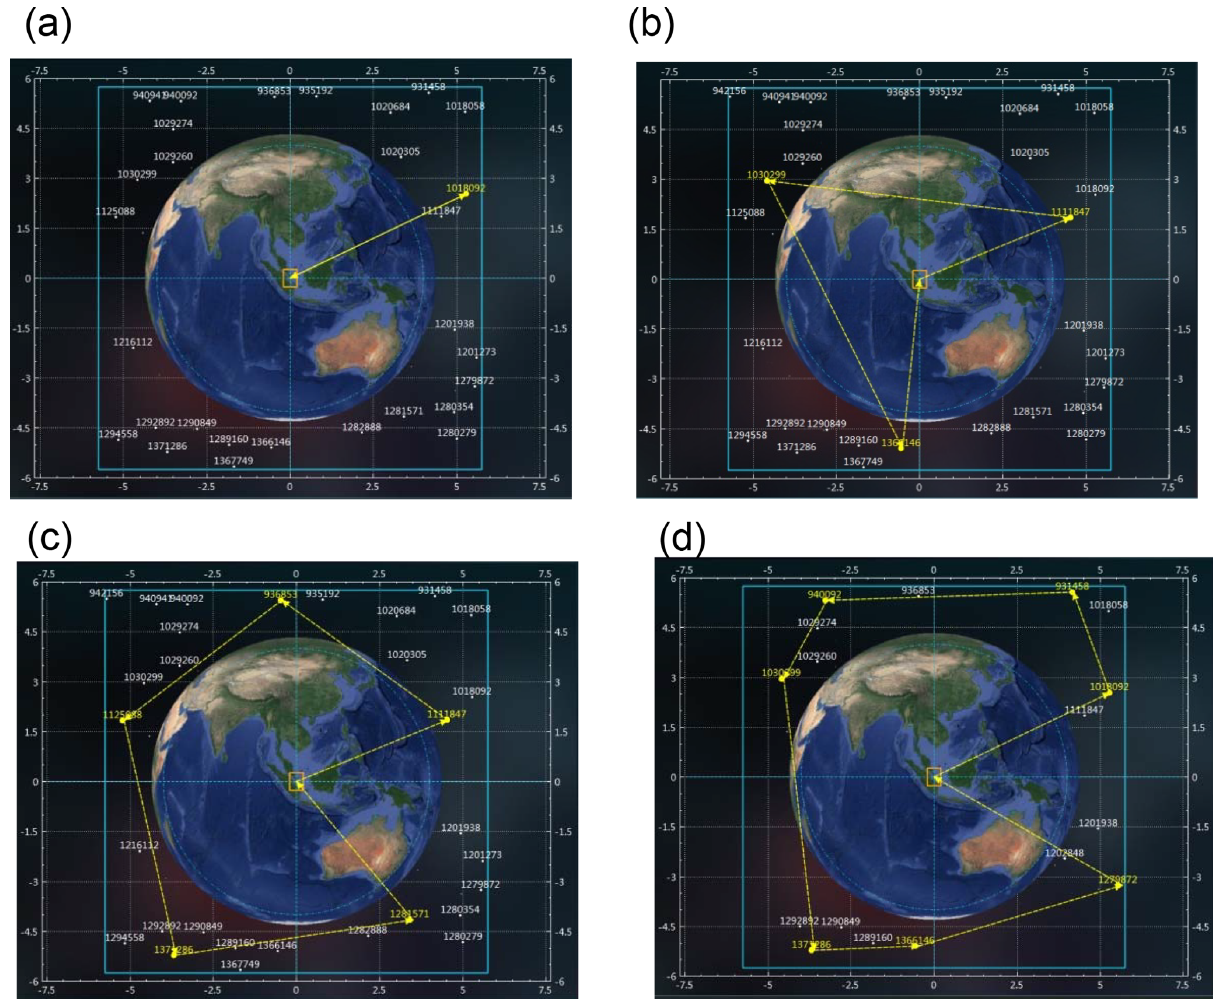
Figure 11. GIIRS star selection results – without the sun: (a) the result of choosing one star, (b) the result of choosing three stars, (c) the result of choosing five stars and (d) the result of choosing seven stars.